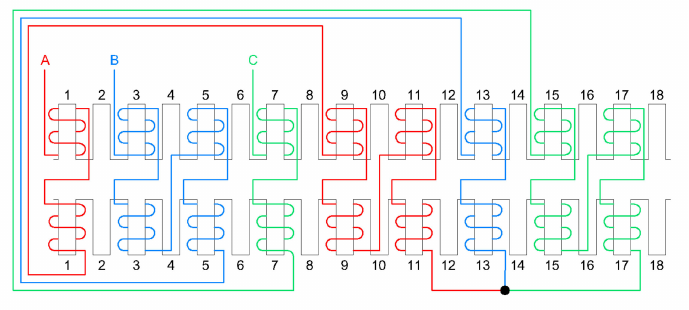
Figure 5. The scheme of the concentrated